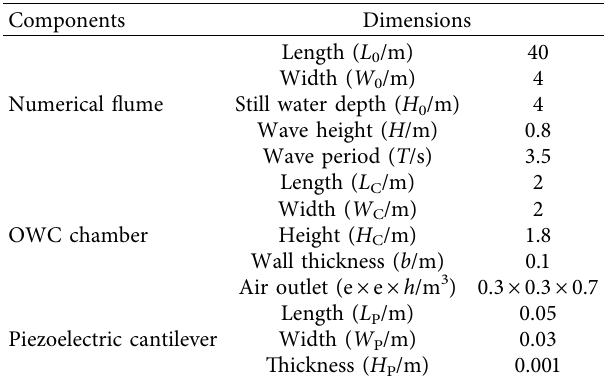
Figure 4: Simulation of the 3D numerical wave energy harvesting system. (a) Volume fraction of the flume and chamber. (b) Vortex shedding diagram at the outlet of air chamber ( T � 0.4s). Table 1: Parameters of the 3D numerical model of the wave energy harvester.